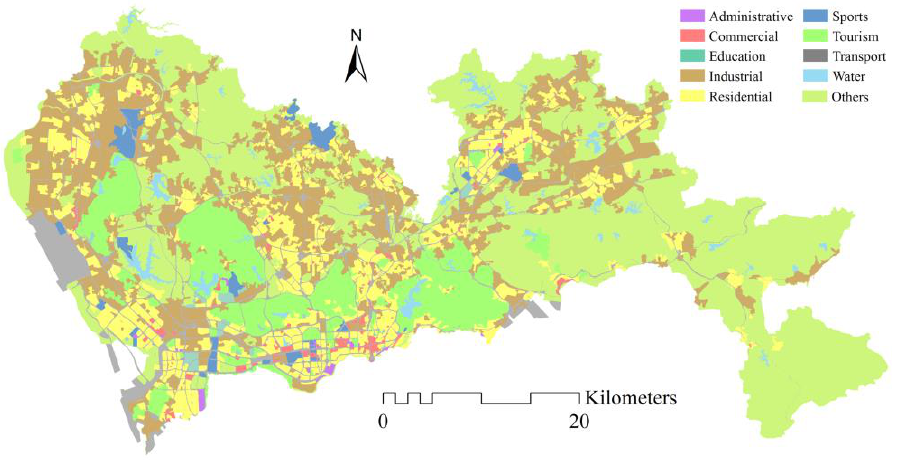
Figure 2. Spatial distribution of urban functional regions.